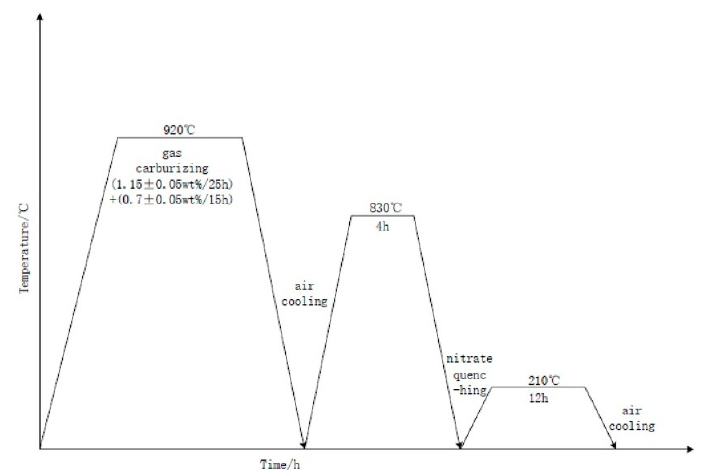
Figure 1. Carburizing and quenching process